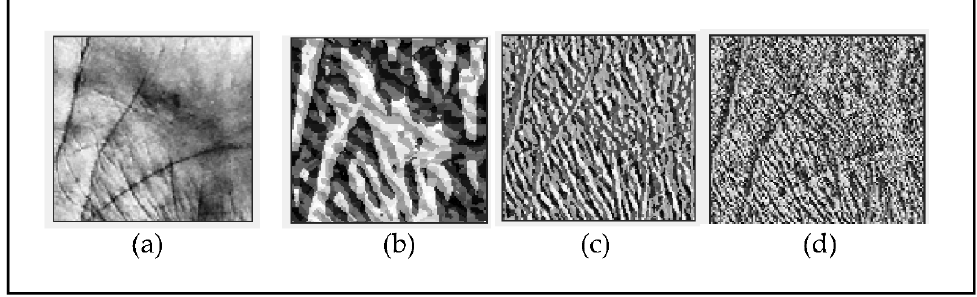
Figure 3. Example of BSIF conversion results for ( a ) original image, ( b ) l × l = 17 × 17, n = 8, ( c ) l × l = 9 × 9, n = 12, and ( d ) l × l = 3 × 3, n = 8 .